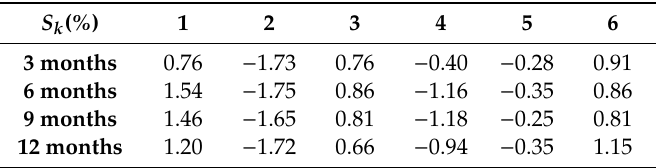
Table 5. Spread of each array in each